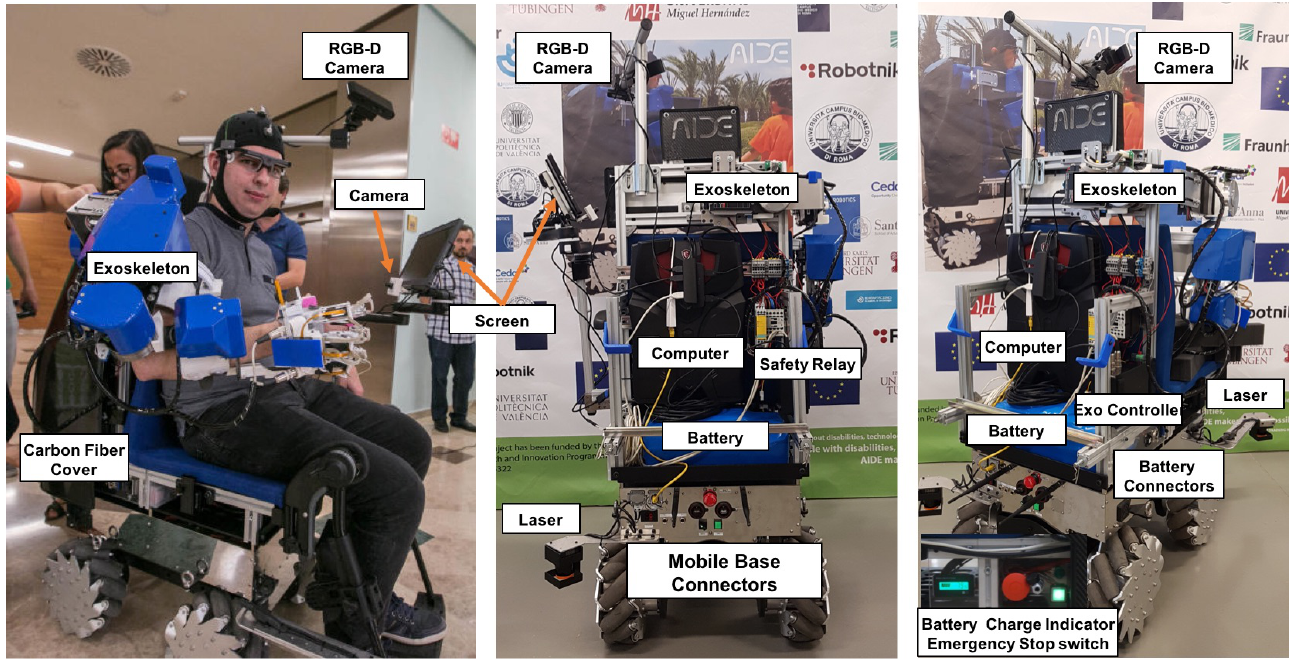
Figure 1. The parts of the platform are shown. The computer, battery, connections with the other components, and the safety relay are located on the back side of the prototype protected by a carbon fiber cover. Safety is a key issue in wearable robotics, so there are three emergency stop switches: (1) on the left side of the robotized wheelchair; (2) on the back side of the robotized wheelchair; and (3) connected through a wire to the left side of the